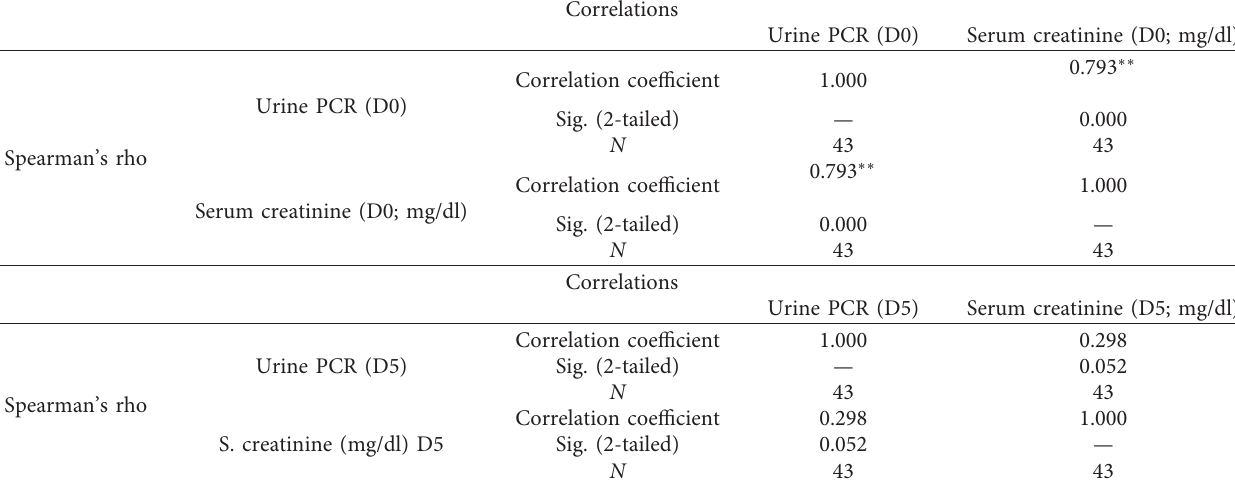
Table 5: Correlation between proteinuria (urine PCR) with renal failure (serum creatinine).